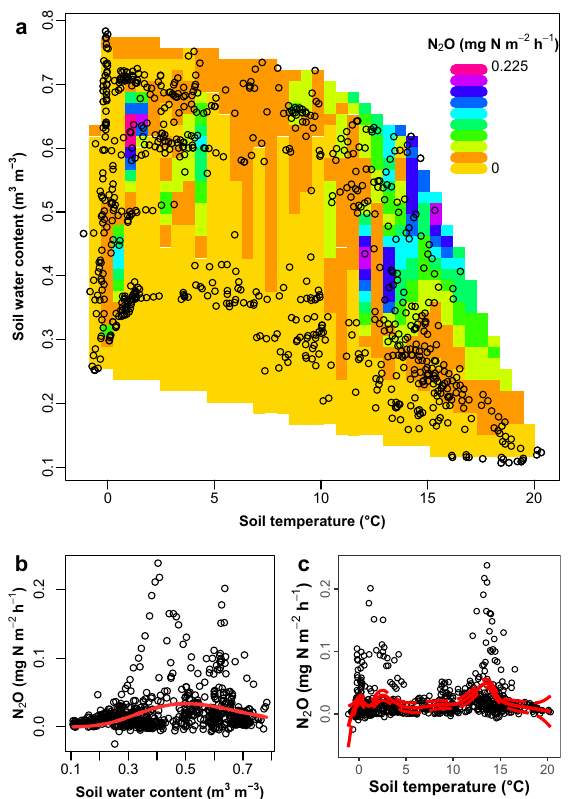
Fig. 2 Relationships between the soil temperature, soil water content (SWC), and fl ux of N 2 O from the soil over the study period. a Contour plot showing relationships between soil temperature, SWC, and N 2 O emission ( n = 755). b Regression curve of SWC vs. N 2 O fl uxes. Curve fi tted regression of SWC and N 2 O fl ux ( R 2 = 0.07, p < 0.01, n = 757). N 2 O = (15725.05 × SWC 7.73 ) × exp ( − 15.38 × SWC). c Regression curve of soil temperature vs N 2 O. Local polynomial regression fi tting of soil temperature and N 2 O fl ux ( R 2 = 0.13, p < 0.01, n = 756). The dashed red lines represent 95% con fi dence intervals for the regression line.